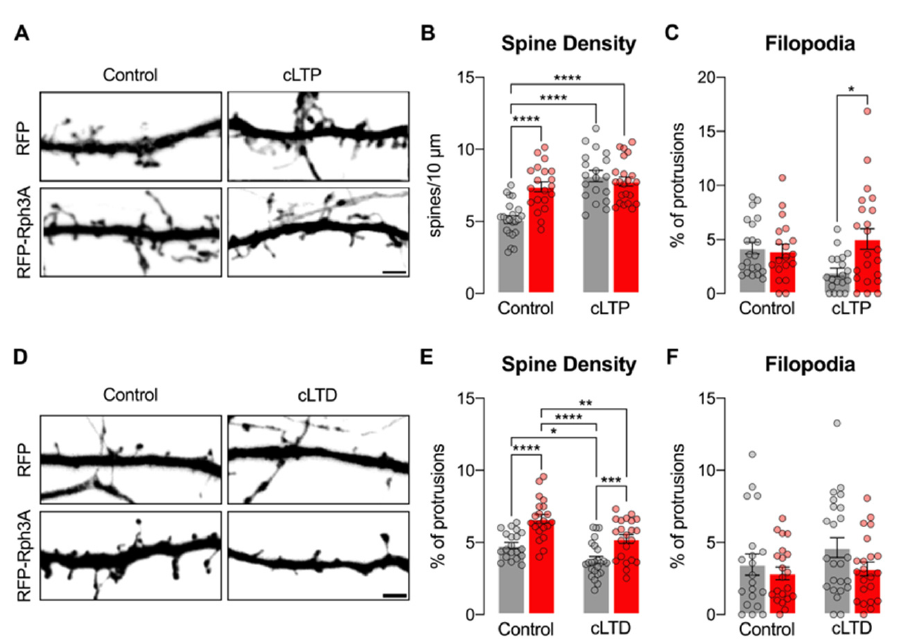
Figure 6. Rph3A affects cLTP but not cLTD. ( A ): Confocal images of GFP filler in the dendritic spines of RFP ( up ) or RFP-Rph3A ( down ) transfected neurons under control conditions ( left ) or after cLTP ( right ). Scale bar: 2 µ m. ( B , C ): Bar graph representation of mean ± SEM spine density ( B ) and mean ± SEM filopodia proportions ( C ) in RFP (grey) or RFP-Rph3A (red) transfected neurons under control conditions or after cLTP. One-way ANOVA with Tukey post-hoc test. ( D ): Confocal images of GFP filler in the dendritic spines of RFP ( up ) or RFP-Rph3A ( down ) transfected neurons under control conditions ( left ) or after cLTD ( right ). Scale bar: 2 µ m. ( E , F ): Bar graph representation of mean ± SEM spine density ( E ) and mean ± SEM filopodia proportions ( F ) in RFP (grey) or RFP- Rph3A (red) transfected neurons under control conditions or after cLTD. One-way ANOVA with Tukey post-hoc test. * p < 0.05; ** p < 0.01; *** p < 0.001; **** p < 0.0001. Dots represent single